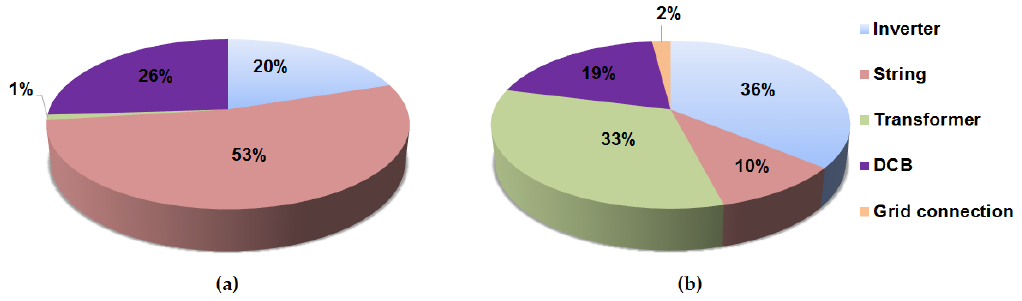
Figure 8. Share of failure occurrences ( a ) and associated EL divided by subsystems ( b ) for a CI scheme.